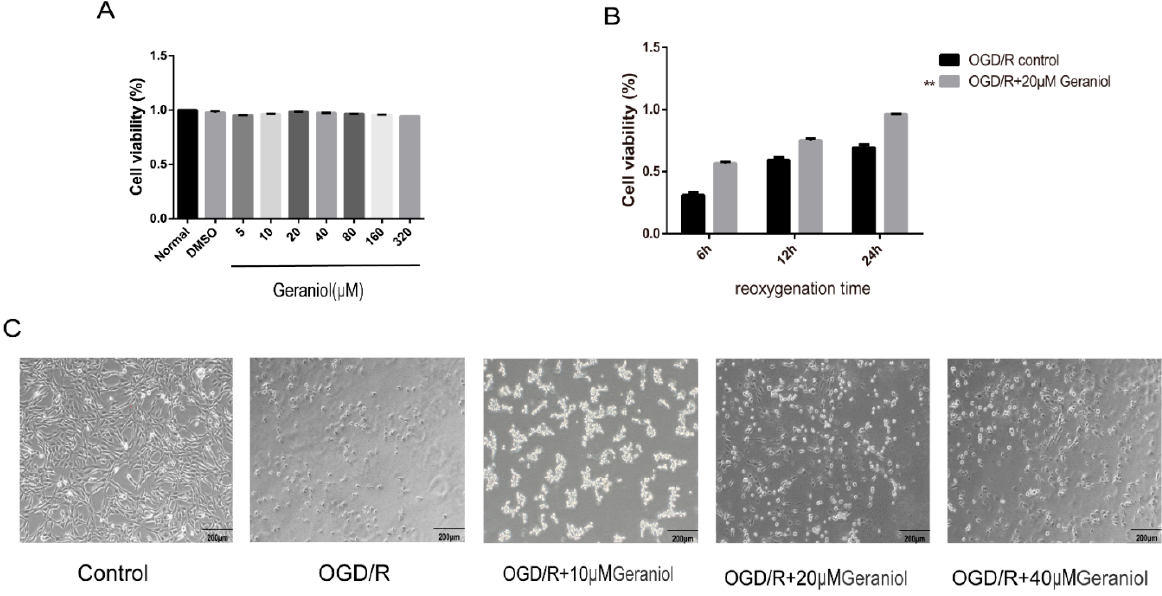
Figure 7. Geraniol increases the cellular activity of oxygen–glucose deprivation/reoxygenation (OGD/R)-induced PC12 cells. ( A , B ) Cell viability was assayed using the CCK-8 kit ( n = 3). ( C ) Microscopic observation of OGD/R-treated PC12 cell morphology. ( B ) ** p < 0.01 OGD/R + 20 µM geraniol group vs. OGD/R control group.